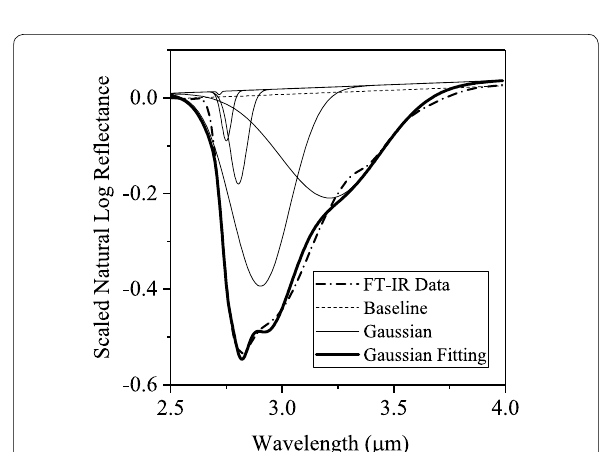
Fig. 7 NIR reflectance spectra for powdered carbonaceous chondrites in the wavelength range of 2.1–3.2 μm. a FT-IR spectra, b uncorrected NIRS3 spectra, c Murchison spectra with error bars measured by NIRS3) and d NIRS3 spectra corrected by method 1, and e those by method 2 are shown. Spectrum of Allende meteorite is not presented in e because it is used as the standard spectrum to correct other spectra